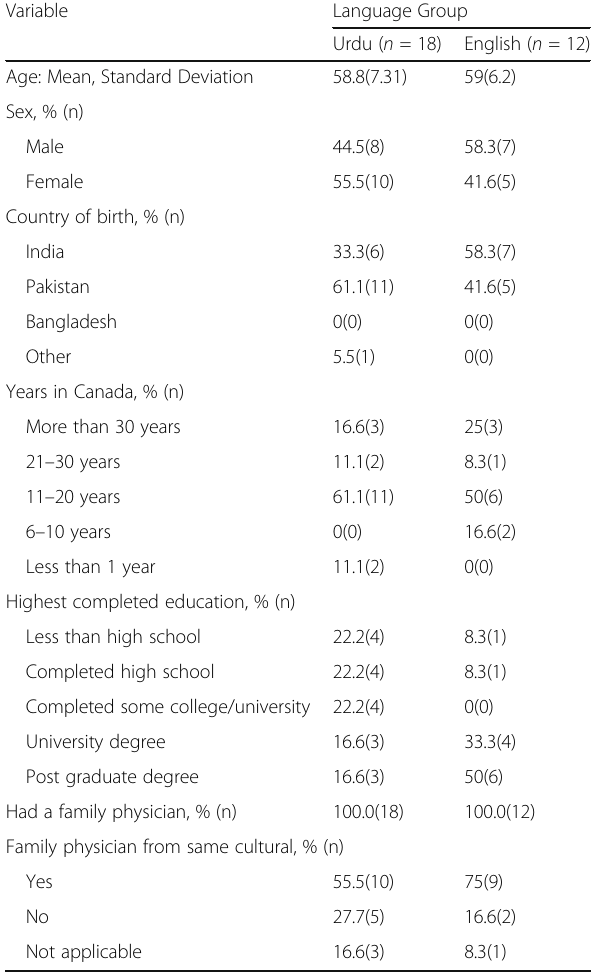
Table 2 Participant Socio-demographic Characteristics